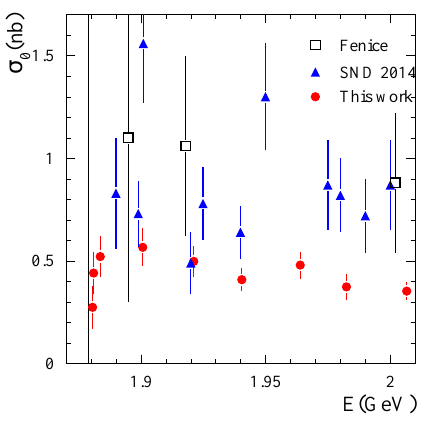
Figure 6. The cos θ distribution for data e + e − → n ¯ n events at the energies 1960, 1980, 2000 MeV. The histogram is the result of the fit with | G E | =